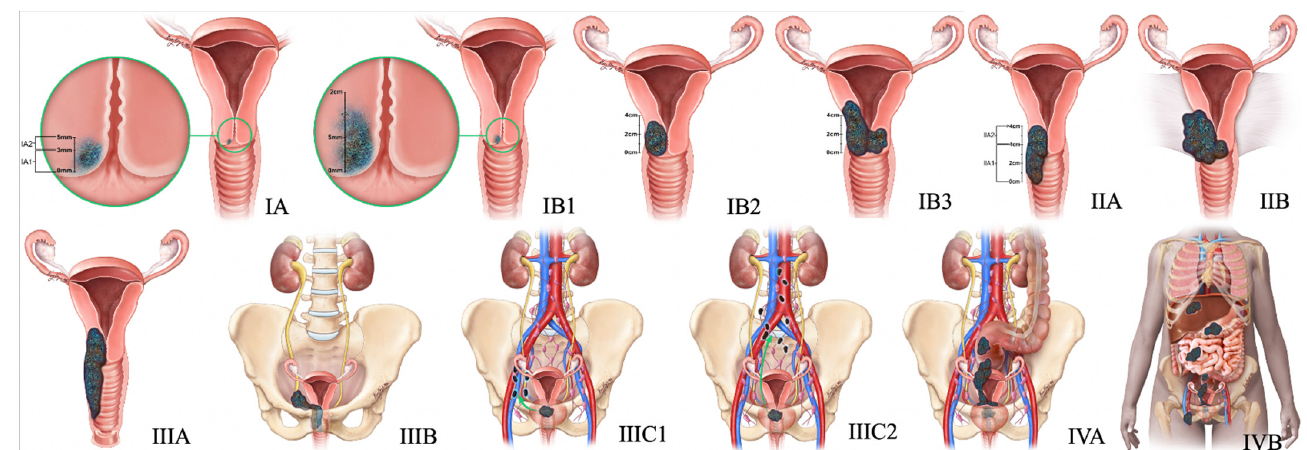
Figure 5. 2018 FIGO staging system for cervical cancer. Stage I, confined to the cervix. Stage IA, ≤ 5